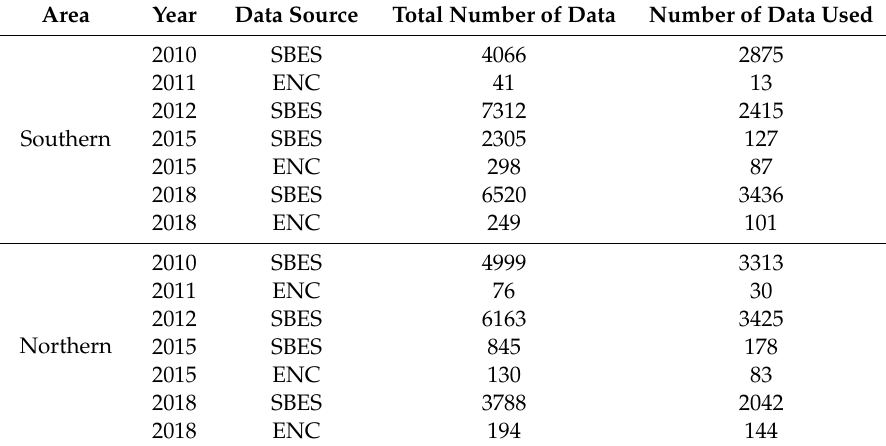
Table 4. Number of data contained in ENC and